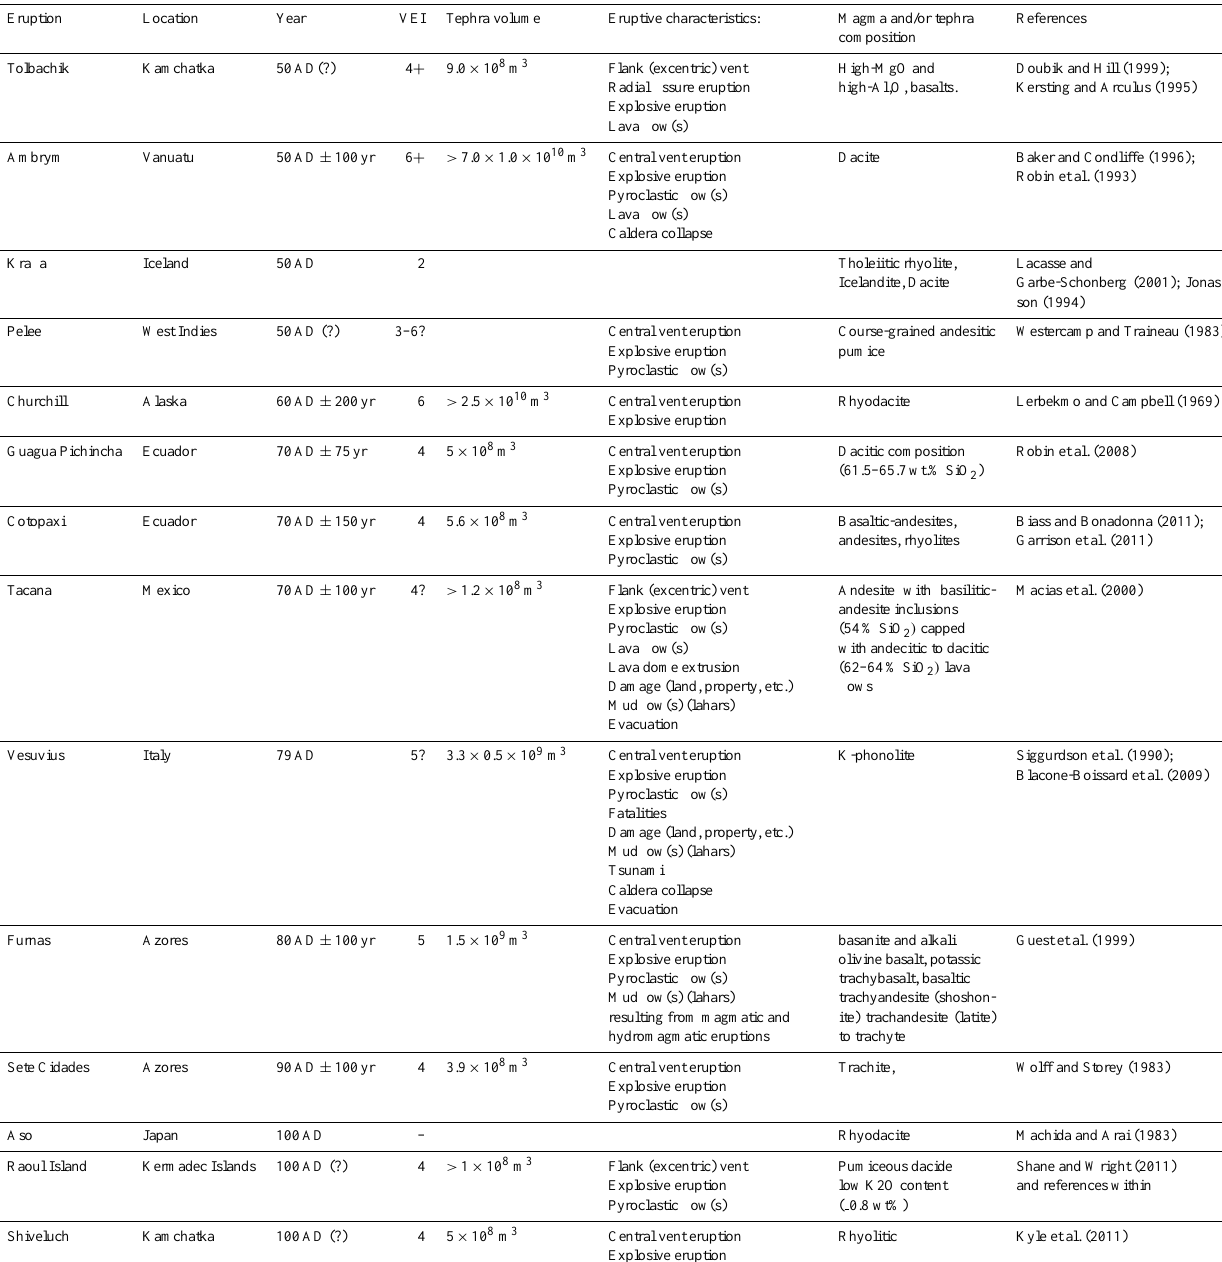
Table 2. Known major volcanic eruptions between 50–100AD. The Krafla, Iceland, eruption is included due to its proximity to the GRIP ice core site. Other than the Krafla and Asos eruptions, the volcanic explosivity index (VEI) data are compiled in the Smithsonian Global Volcanism Program (http://www.volcano.si.edu/world/largeeruptions.cfm).